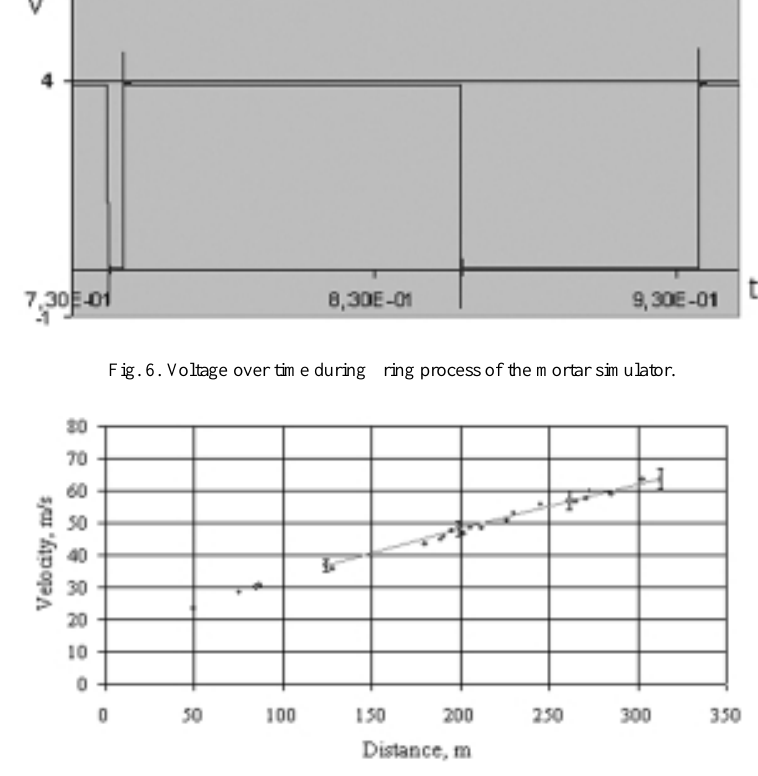
Fig. 7. Comparison between experimentally (dots) and numerically (solid line) reconstructed relationships between the initial velocity and the flight distance of the warhead. in mind the scaled geometrical similitude it is assumed that the coefficient h (Eq. (3)) is the same for the